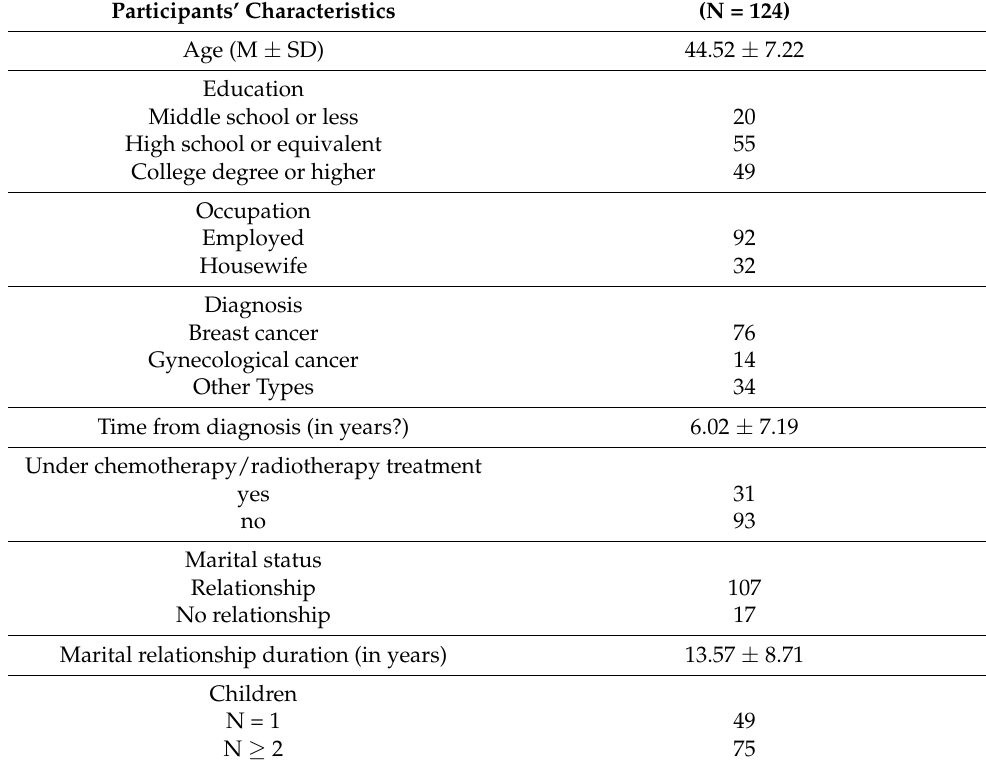
Table 1. Demographic and clinical characteristics of the study participants (N =